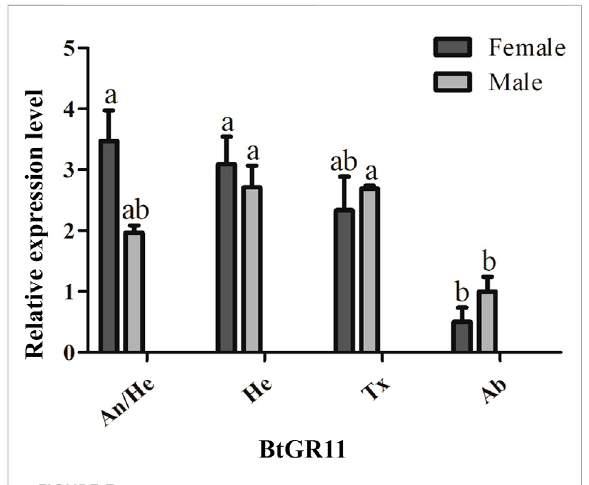
FIGURE 3 Tissue expression pro fi les of the BtGR11 gene. Female: female adult; Male: male adult; An/He: head with antennae; He: head without antennae; Tx: thorax; Ab: abdomen.